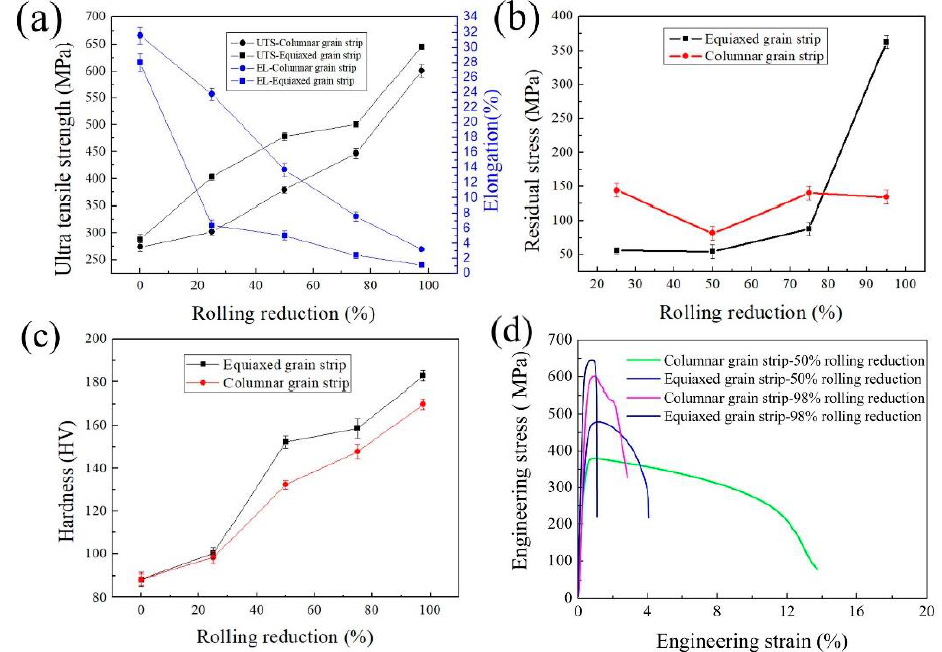
Figure 4. Mechanical properties and residual stress of C70250 copper alloy during cold rolling. ( a ) Strength and elongation; ( b ) Residual stress; ( c ) Hardness; ( d ) Engineering stress-strain curve.